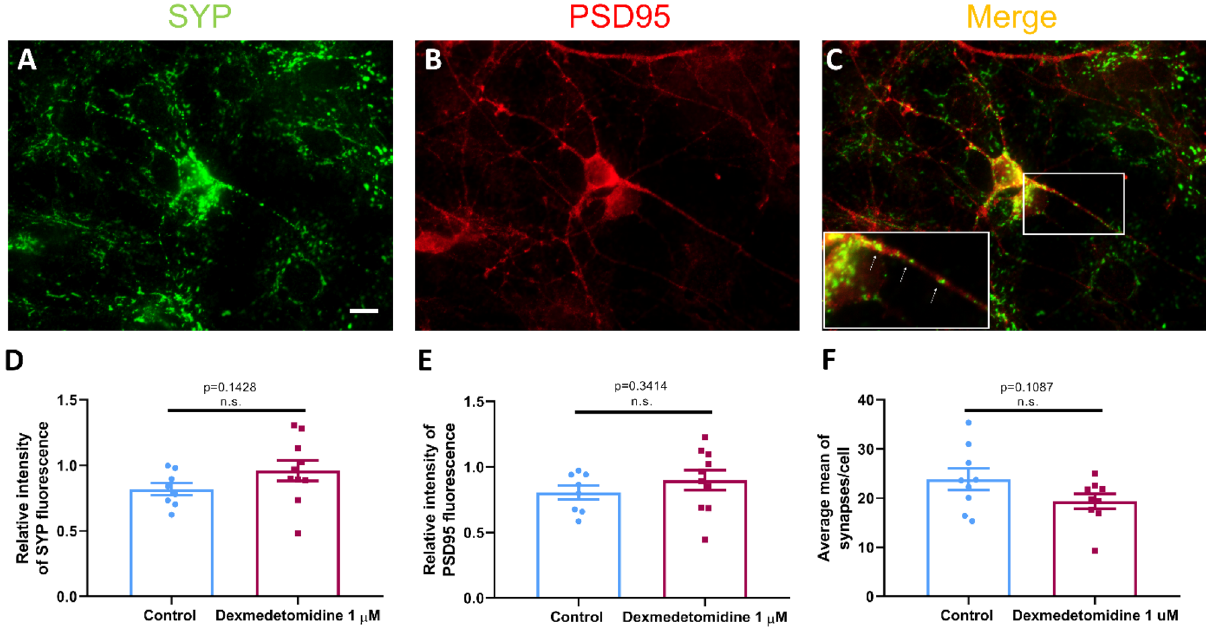
Figure 3. Exposure to 1 μM dexmedetomidine did not affect synapse formation. Representative fluorescent images of neurons stained with SYP (green) and PSD95 (red). ( A ) SYP and ( B ) PSD95 images of control cells. ( C ) SYP/PSD95 merge with close-up look at a synaptic puncta. Quantification of ( D ) relative intensity of SYP fluorescence: control = 0.82 ± 0.048 (n = 8), dexmedetomidine 1 μM = 0.961 ± 0.078 (n = 10). Values are mean ± SEM t = 1.551, df = 14.32, p = 0.143 by two-tailed t test, Welch-corrected and ( E ) relative intensity of PSD95 fluorescence: control = 0.805 ± 0.053 (n = 8), dexmedetomidine 1 μM = 0.89 ± 0.076 (n = 10). Values are mean ± SEM t = 1.025, df = 15.24, p = 0.341 by two-tailed t test, Welch-corrected and ( F ) average number of synapses per cell: control = 23.9 ± 2.17 (n = 9), dexmedetomidine 1 μM = 19.37 ± 1.517 (n = 9). Values